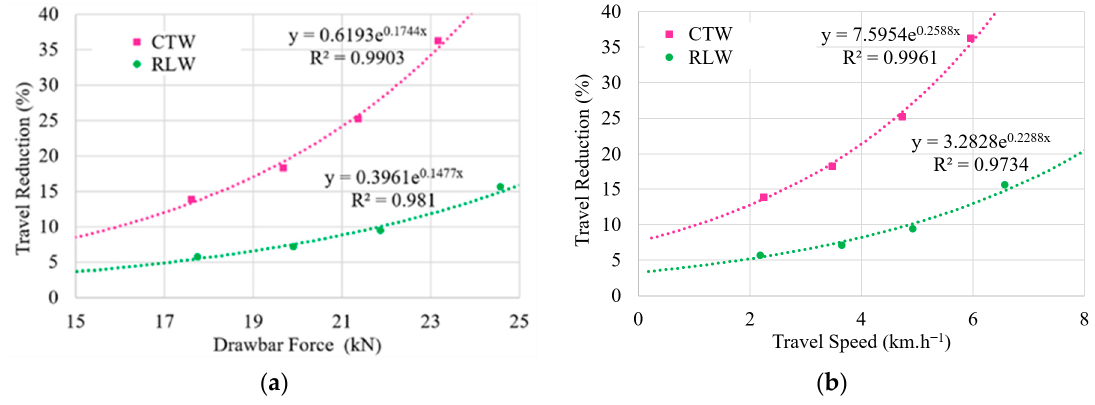
Figure 5. Traction performance analysis of CTW and RLW by travel reduction response of tractor with both wheels at increasing ( a ) drawbar loads and ( b ) travel speeds.